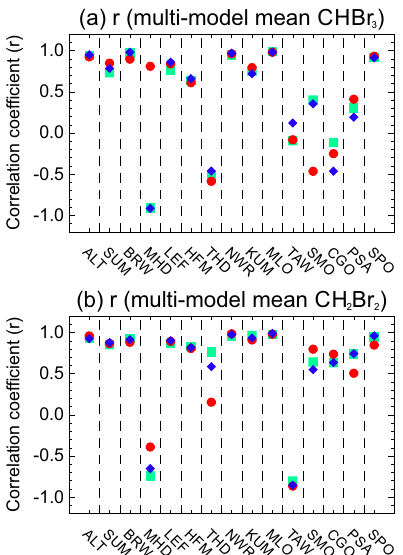
Figure 5. Correlation coefficient ( r ) between observed and multi- model mean (a) CHBr 3 and (b) CH 2 Br 2 , at ground-based monitor- ing sites. The correlation here represents the mean annual seasonal variation. At each site, 3 × r values are given, reflecting the three different model CHBr 3 tracers; green squares denote the CHBr 3 _L tracer (top-down derived, Liang et al., 2010, emissions), blue dia- monds denote the CHBr 3 _O tracer (top-down Ordóñez et al., 2012, emissions) and red circles denote the CHBr 3 _Z tracer (bottom-up Ziska et al., 2013,